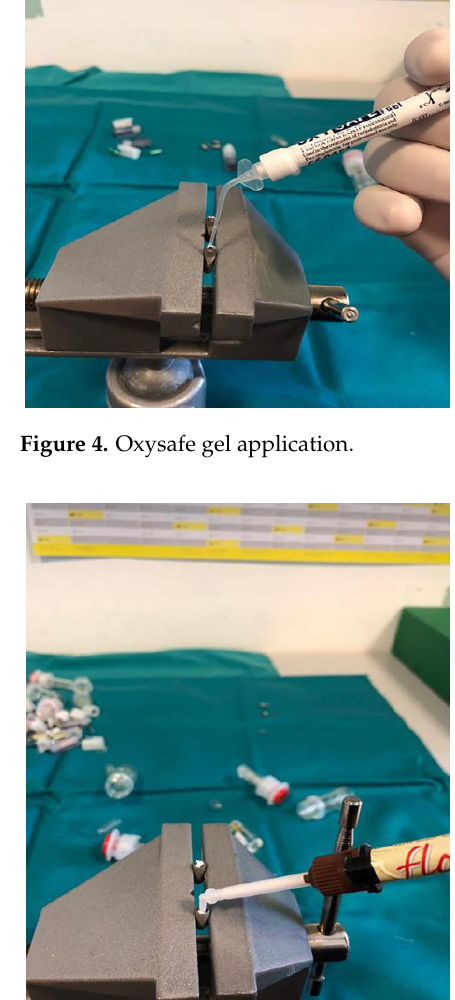
Figure 5. Flow.sil application.